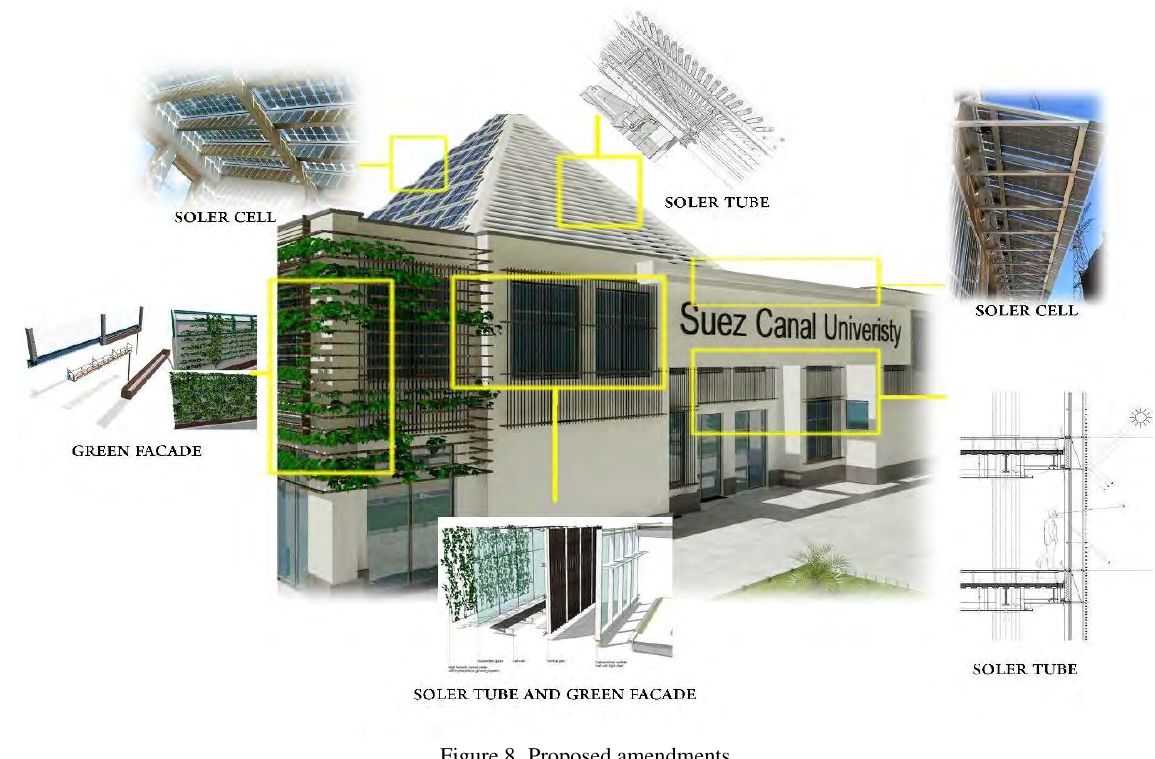
Figure 8. Proposed amendments